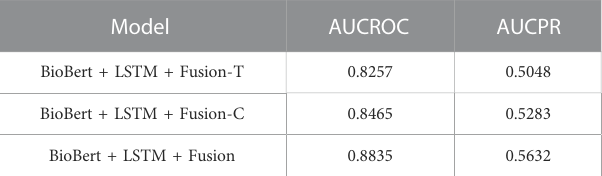
TABLE 6 Data Ablation Results (T for time-series, C for clinical records).